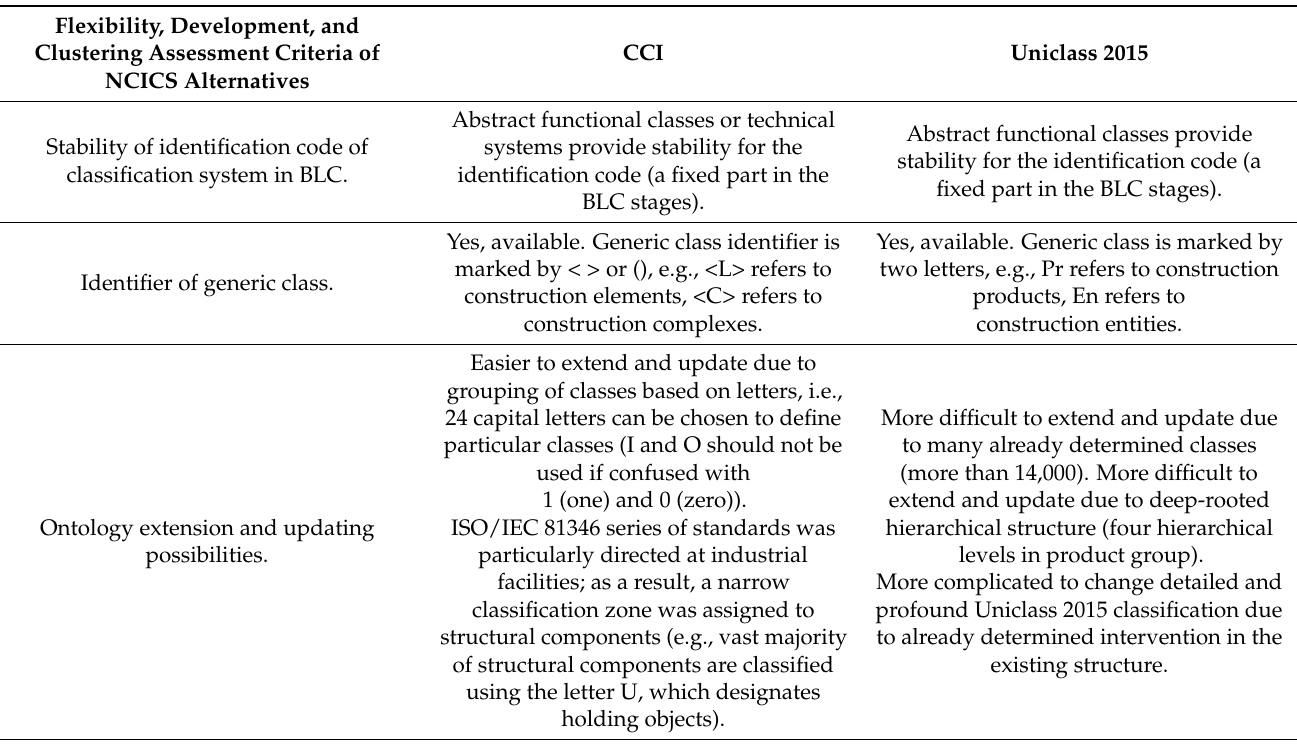
Table 3. NCICS alternatives assessment model in terms of flexibility, development, and clustering